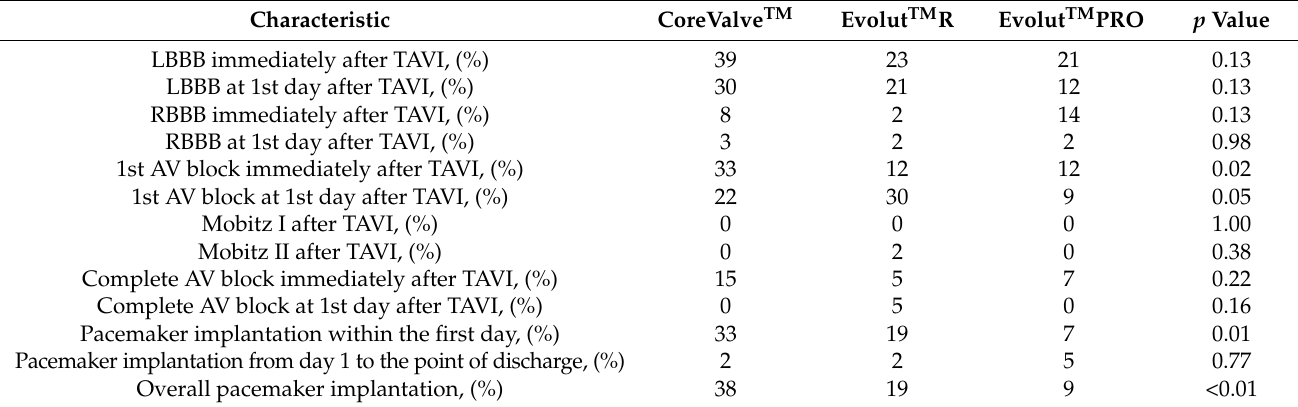
Table 3. Electrocardiographic